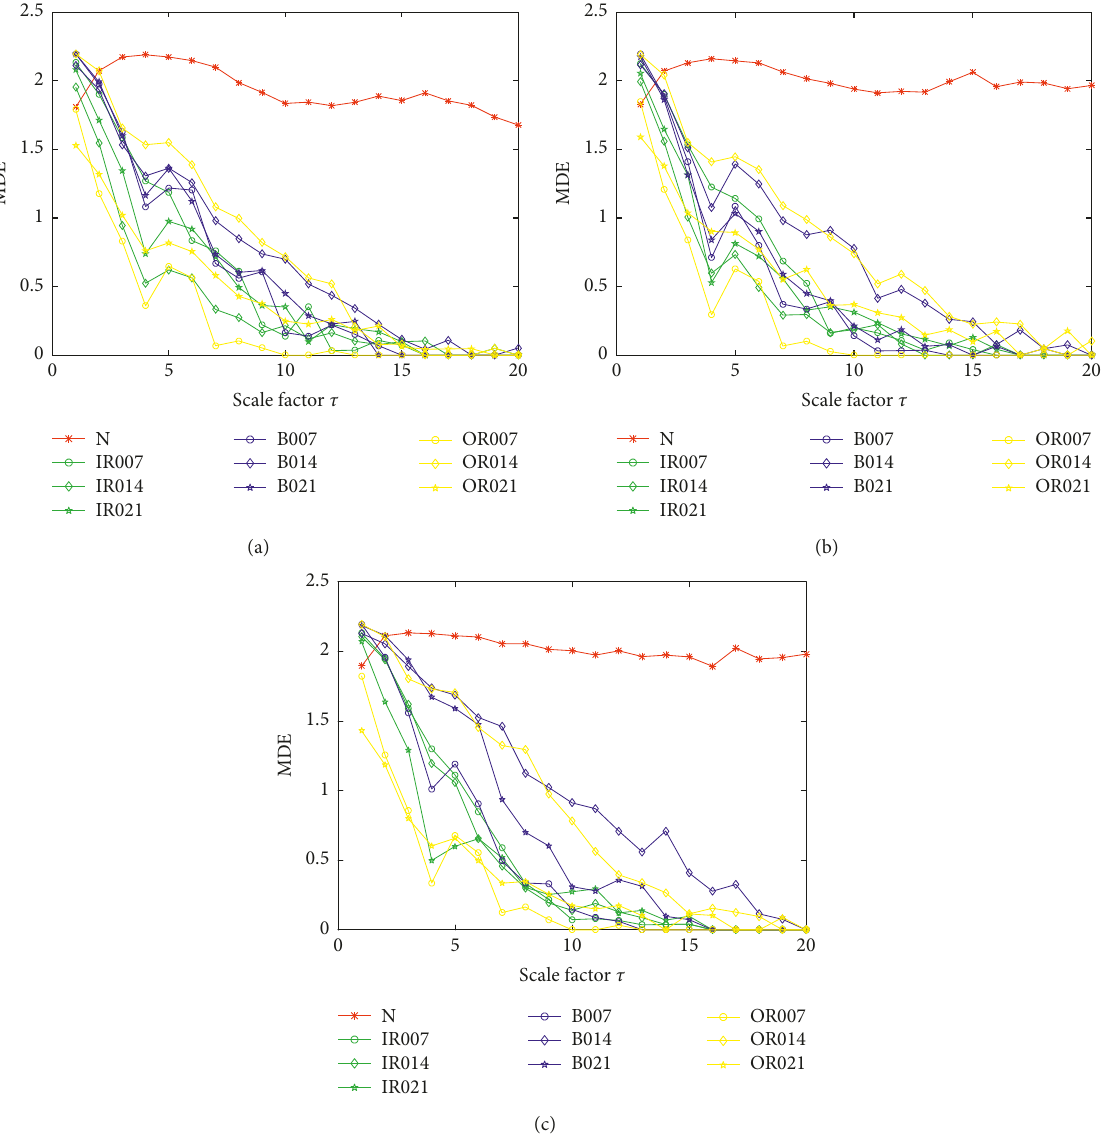
Figure 11: Dispersion entropy of each scale of the vibration signal of the test bearing data set under three kinds of loads. (a) Load � 0 hp. (b) Load � 1 hp. (c) Load �